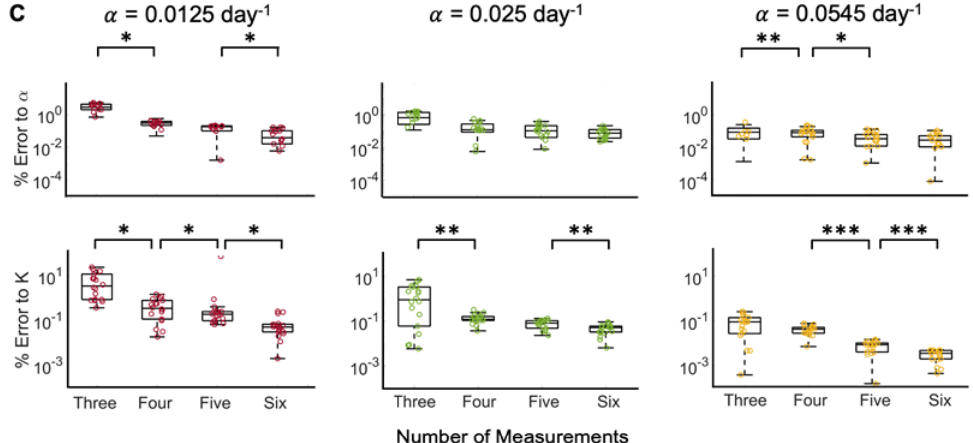
Figure 3. Tumor growth trajectory predictions from optimized model fits to ground truth data for representative patient 9. ( A ) Model fit to data using three, four, five, or six measurements (solid curve) to predict the tumor growth dynamics forward in time (dashed curve) for data generated with the different ground truth growth rates ( α = 0.0125 (red), 0.025 (green), or 0.0545 day − 1 (yellow)). The black markers are the original tumor volumes taken from Heuser et al., whereas the colored markers represent the interpolated tumor volumes at days 7, 30, 60, 90, and 120. Since the interpolated data points are specific to each growth rate, the color of the marker matches the color of the curve from which the point was interpolated. ( B ) Relative mean square error (MSE) between model fit and prediction and data generated as a function of number of measurements included in model fit, with the different ground truth growth rates, 𝛼 . ( C ) Percent error of model estimated growth rates, 𝛼 , and carrying capacities, K , as a function of the number of measurements included in model fit for the different ground truth growth rates. In B-C , statistical significance is denoted by asterisks (* for p < 0.01, ** for p < 0.005, and *** for p < 0.001).